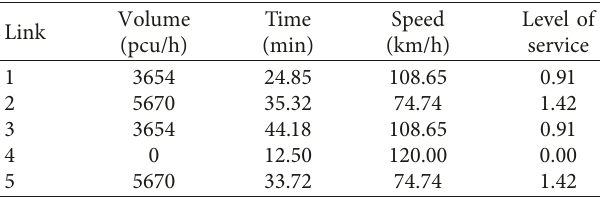
Figure 3: The level of service with population migration. Table 3: The link performances at the maximum population